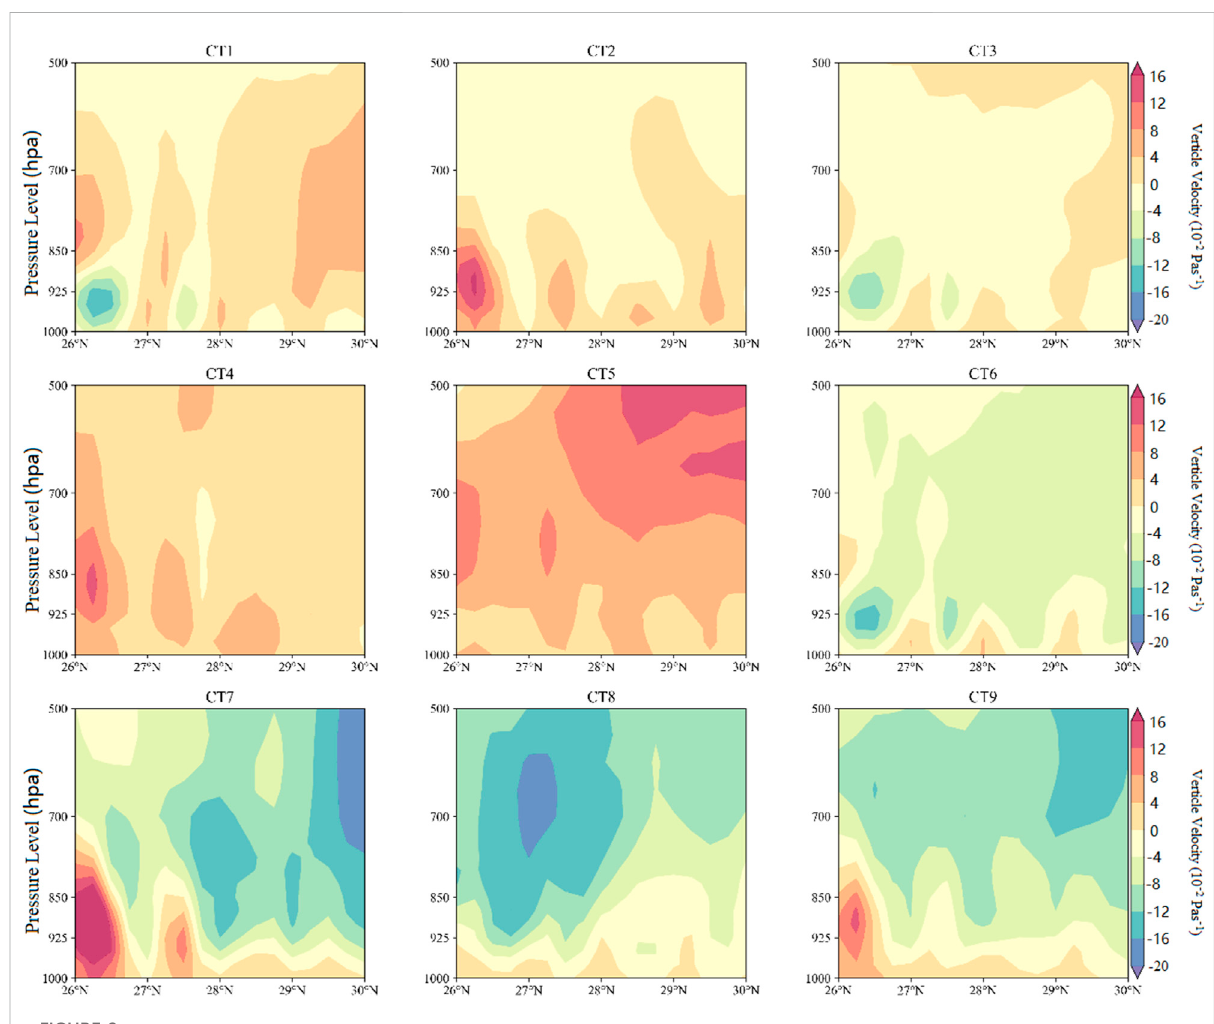
FIGURE 8 Latitude-altitude pro fi le of the vertical wind velocity under the nine CTs in the CZT region, unit: 10 – 2 Pas − 1